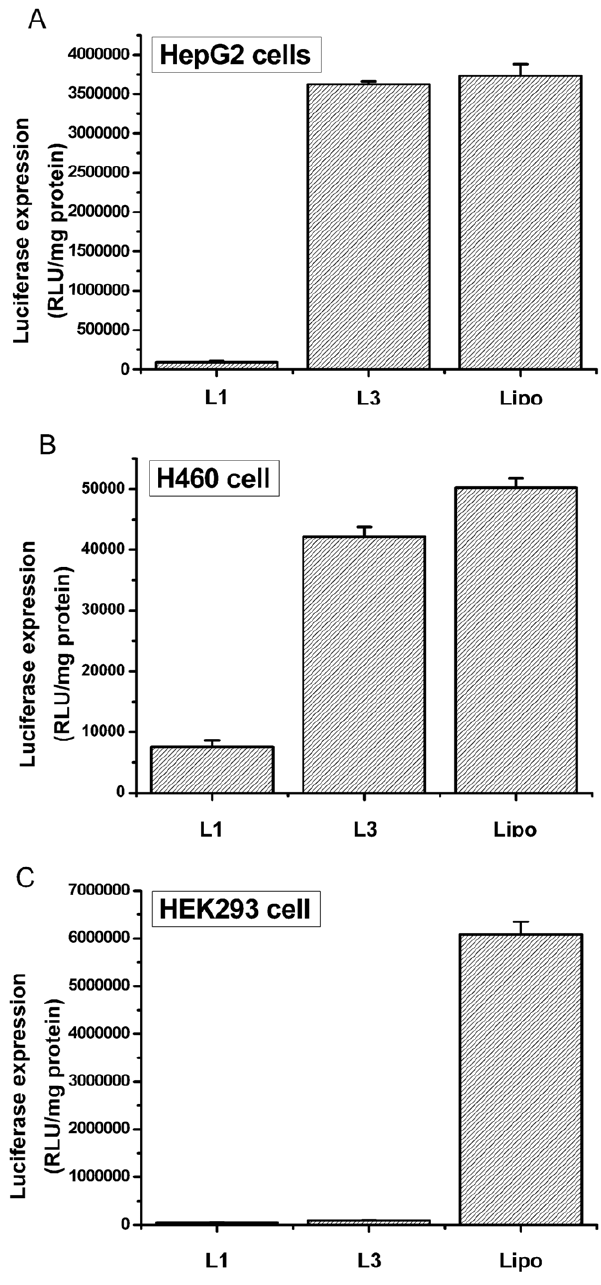
Figure 10. Transfection efficiencies of L1 and L3-based lipoplexes using optimized lipid/DOPE ratio of 1 :2 (for L1 and L3) and optimized N/P ratio of 2 (for L1) and 10 (for L3) in Hep G2 (A), H460 (B) and HEK293 (C) cells. Concentration of the DNA was 2 m g/well and lipofectamine 2000 TM was used as control (Lipo). The data are expressed as relative light units (RLU)/mg of protein.